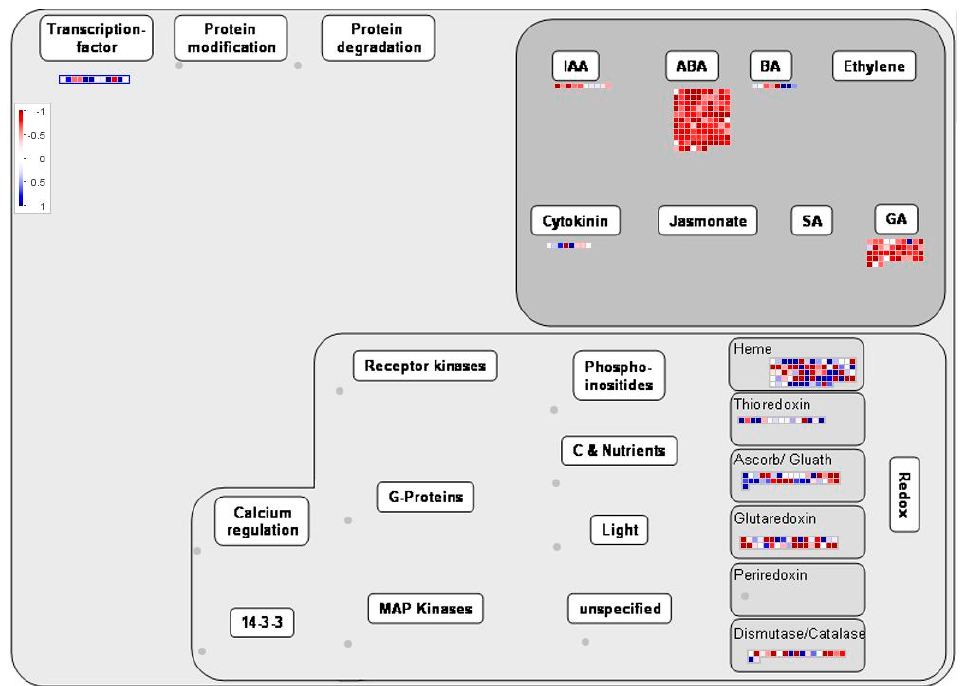
Figure 5. Regulation overview produced by MapMan software. Each color block represents a separate gene; red indicates upregulated expression, and the darker the color, the higher the expression. Blue indicates the down-regulation of expression, and the darker the color, the lower the expression .